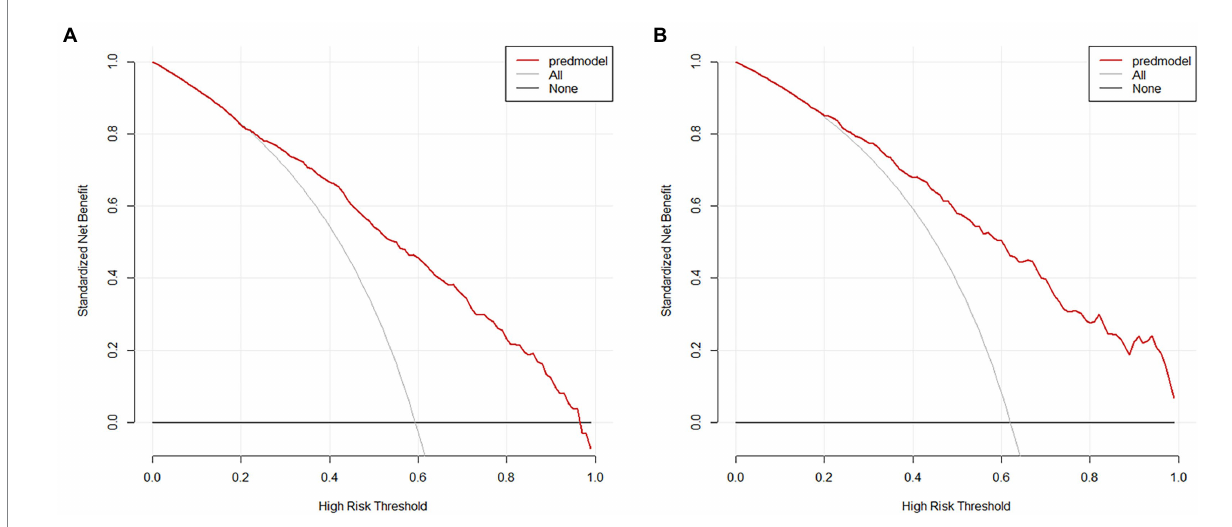
FIGURE 5 Decision curve analysis of the nomogram in the training (A) and validation (B) cohorts.